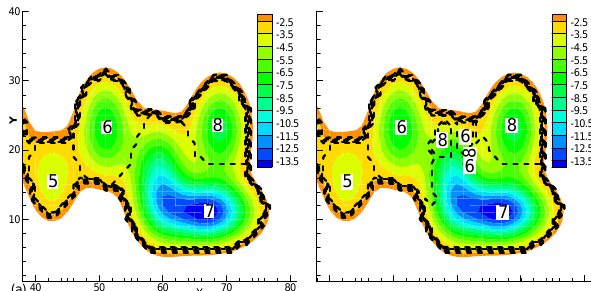
Figure 3. (a) Example of division of a multi-nuclear eddy by present algorithm, where the colour contours represent the SLA, and the numbers identify each eddy. (b) The same example as in (a) but by previous splitting strategies. The eddy boundaries are more zigzag in nature at the vicinity of eddies 6, 7 and 8 than those in (a) . Besides, both eddies 6 and 8 have disconnected areas after splitting.